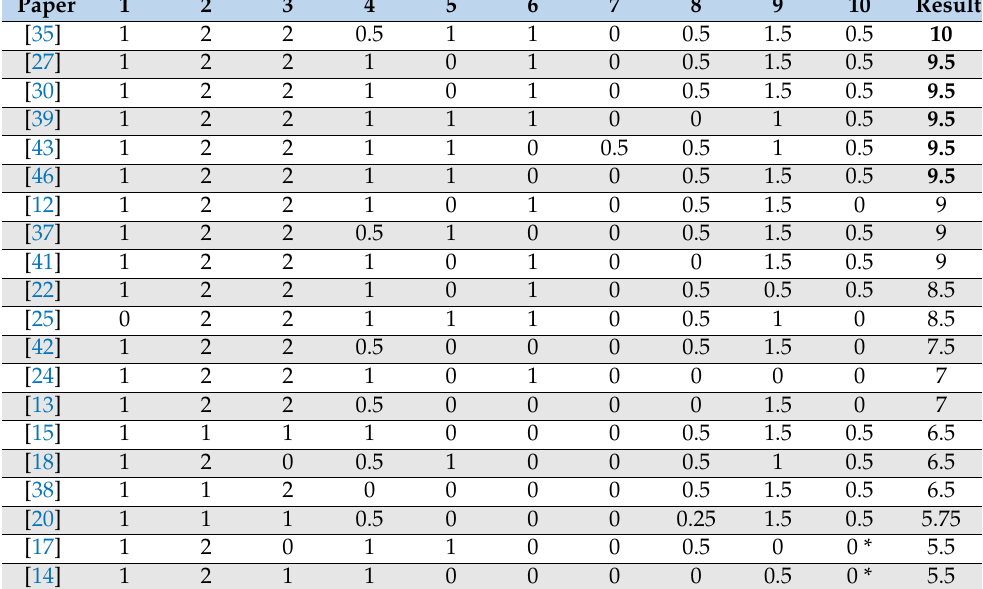
Table 5. Results of the application of the eligibility criteria to the filtered papers. (Results are out of 11, and papers are ordered by the score in descending order). * indicates that the specified paper is